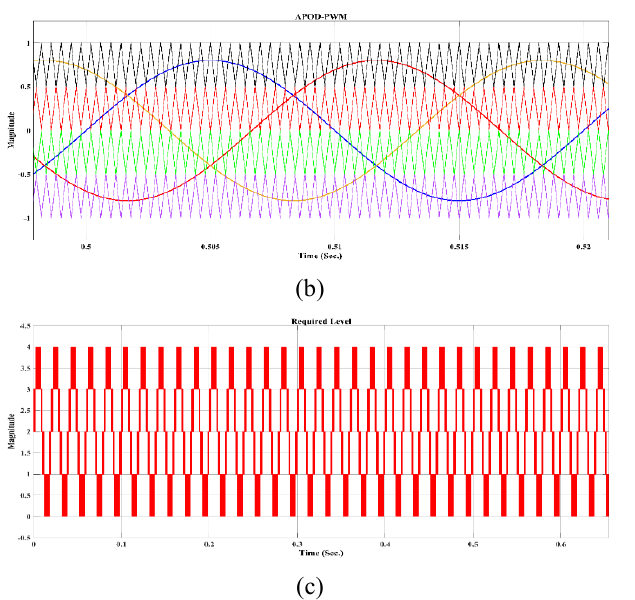
Fig. 4. Simulation Results of the Level Decision Block: (a) PD-PWM, (b)APOD-PWM, (c) Instantaneous